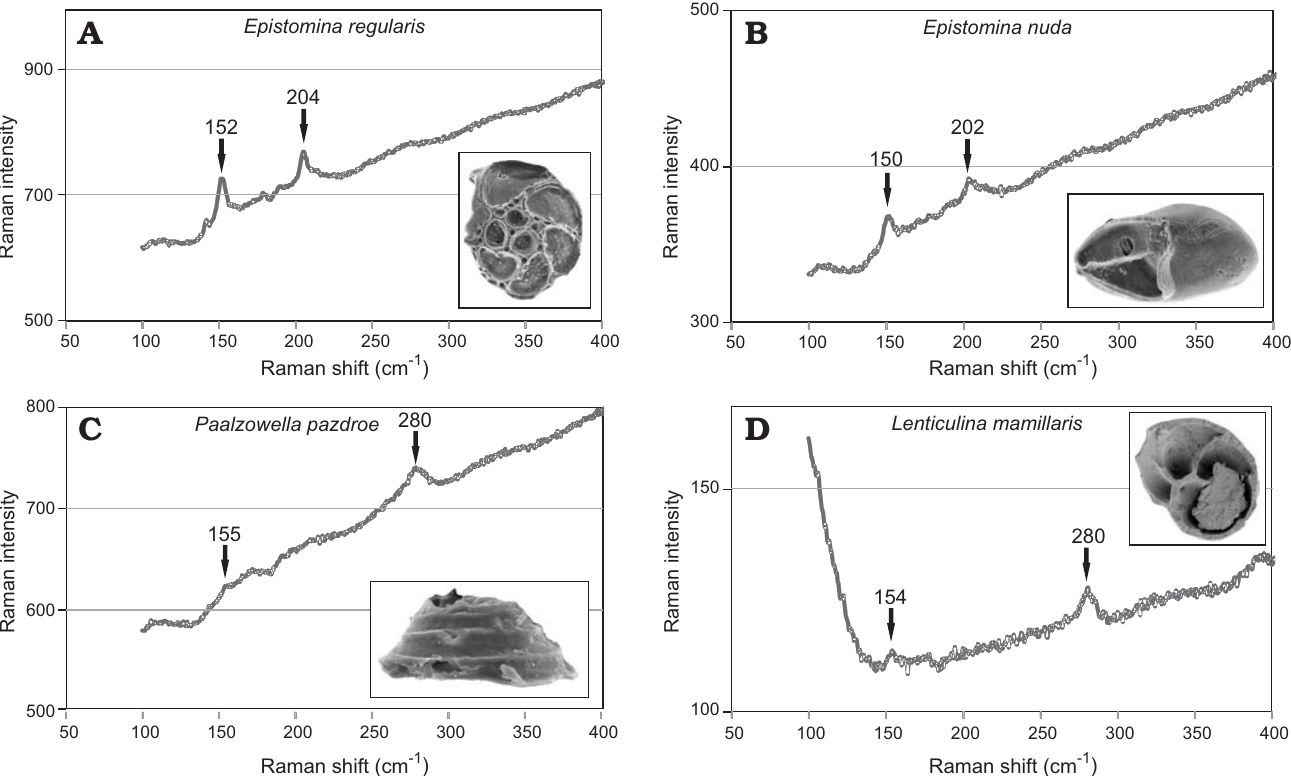
Fig. 2. A , B . Typical spectra of aragonite with well visible peaks at ca. 155 cm − 1 and 204 cm − 1 collected from Robertinida shells from Bathonian clays of Gnaszyn, Poland. A . Epistomina regularis Terquem, 1883, MWGUW ZI/67/63/18. B . Epistomina nuda Terquem, 1883, MWGUW ZI/67/63/08. C , D . Typical spectra of calcite with well visible peaks at ca. 155 cm − 1 and 280 cm − 1 obtained from tests from Bathonian clays of Gnaszyn, Poland. C . Spirillinata, Paalzowella pazdroe Bielecka and Styk, 1969, MWGUW ZI/67/63/07. D . Lagenata, Lenticulina mamillaris Terquem, 1883, MWGUW